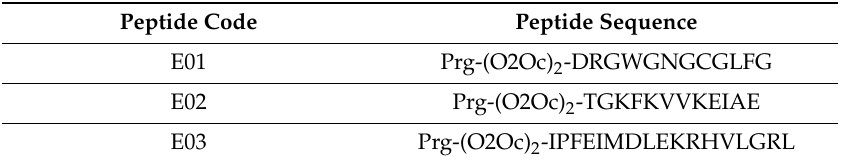
Table 1. Sequences of peptides predicted and tested for immunoreactivity modified with short-chain